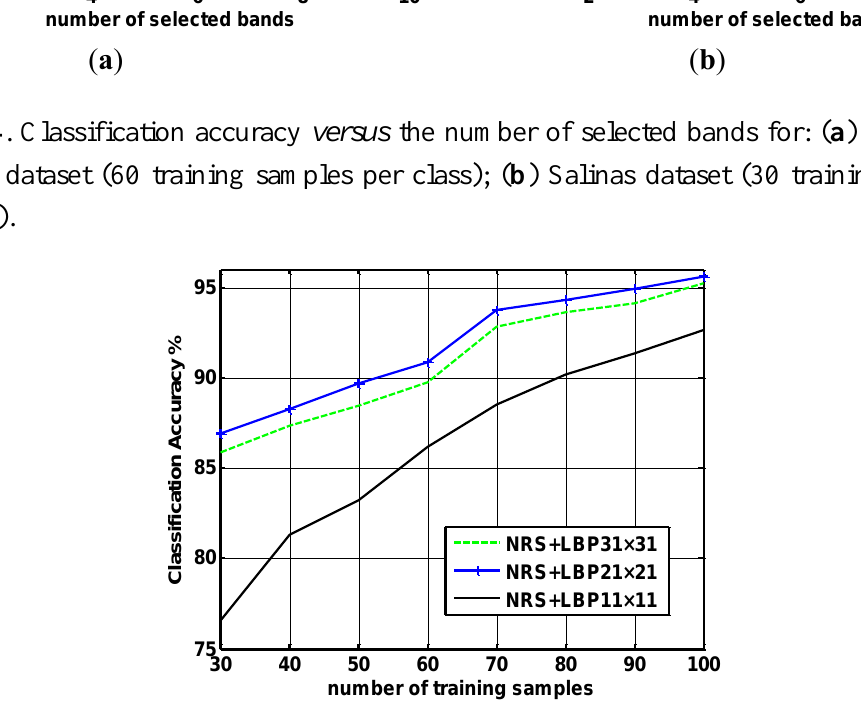
Figure 5. Impact of patch size on LBP generation using the University of Pavia